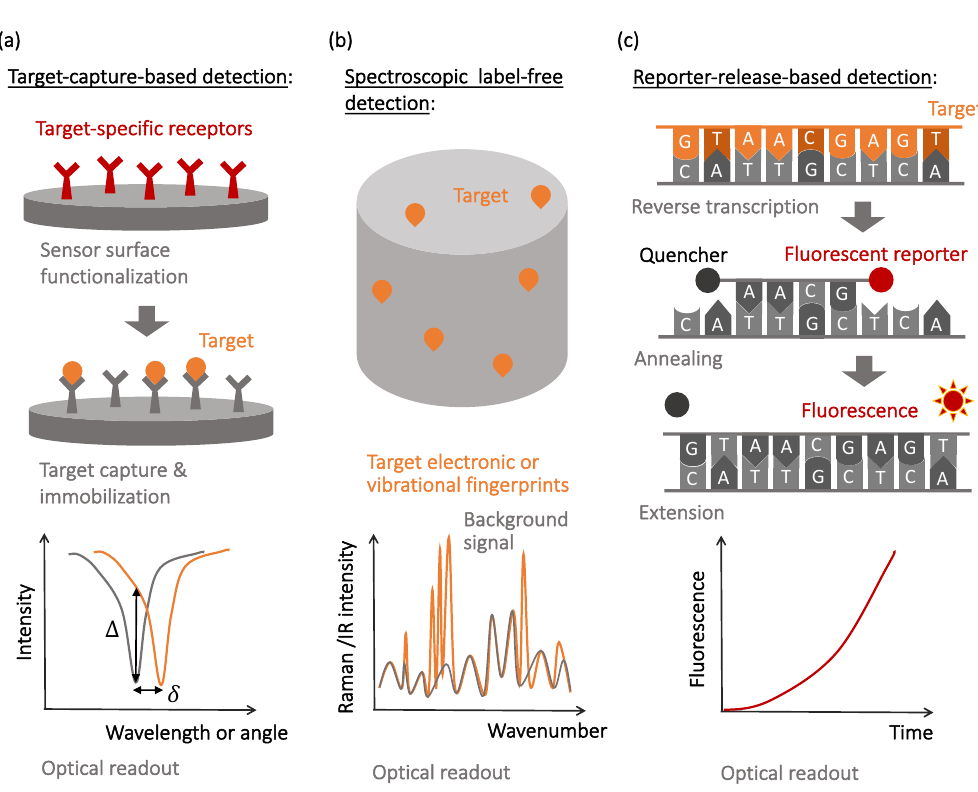
Figure 1. Different detection mechanisms used in bio(chemical)sensors with optical signal readout. ( a ) Target-capture based detection provides selectivity via the use of target-specific receptors (such as antibodies or aptamers) and sensitivity via the use of resonant photonic structures for optical signal amplification. ( b ) Spectroscopic label-free detection provides selectivity by using the native vibrational or fluorescence spectra of the target material and often uses polaritonic surface-mode enhancement mechanisms to increase sensitivity. ( c ) Reporter-release-based detection (illustrated here with an example of the RT-PCR technique) typically provides selectivity via a target-activated release of fluorescent reporters and relies on biological target amplification to increase